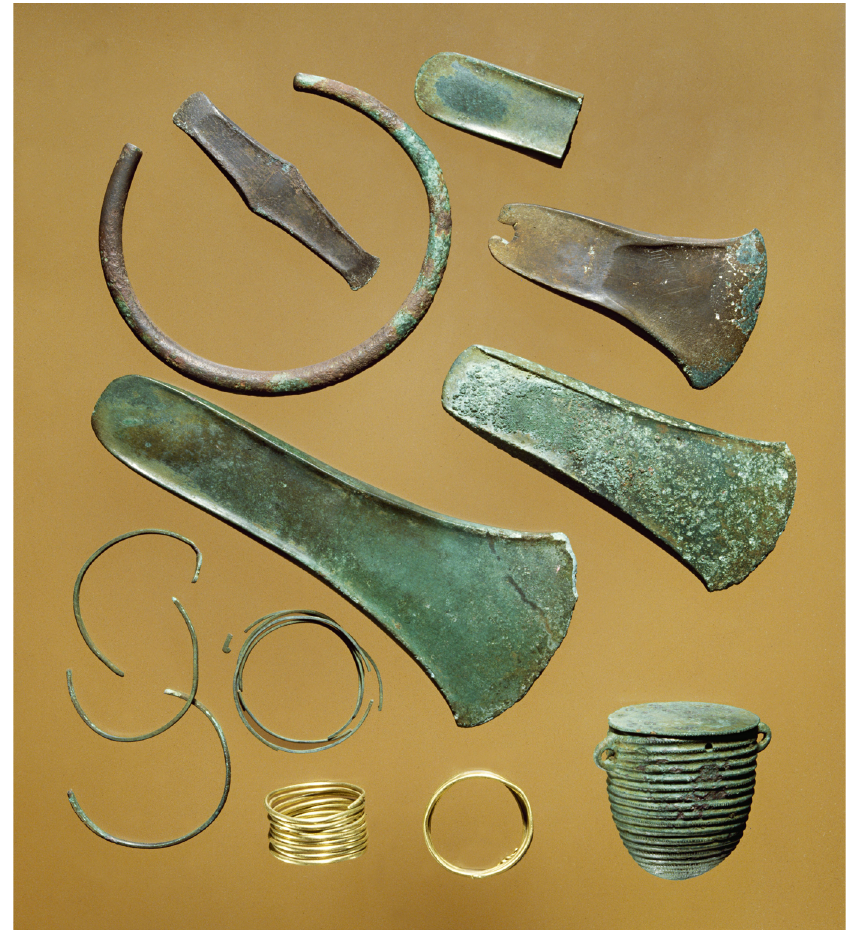
Figure 4. The Skeldal hoard, eastern Jutland. Late Neolithic II. Content: Three flanged axe, a fragment of another axe, a flanged chisel, a solid neck ring, a spiral ring, a spiral bead, two Noppenrings , and a beehive-shaped box with lid containing two gold Noppenrings . Except for the locally made axes, the hoard contains imports from the Únětice area (see Vandkilde 2010 for further details). Photo: Lennart Larsen, The National Museum of Denmark, licence CC